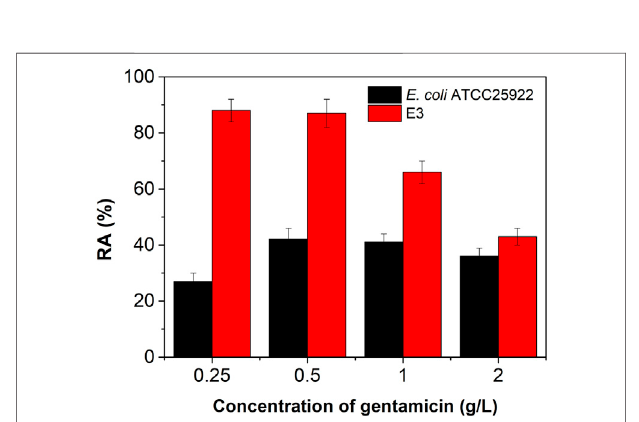
FIGURE 6 | %RA change of E. coli ATCC 25922 and E3 toward gentamicin.